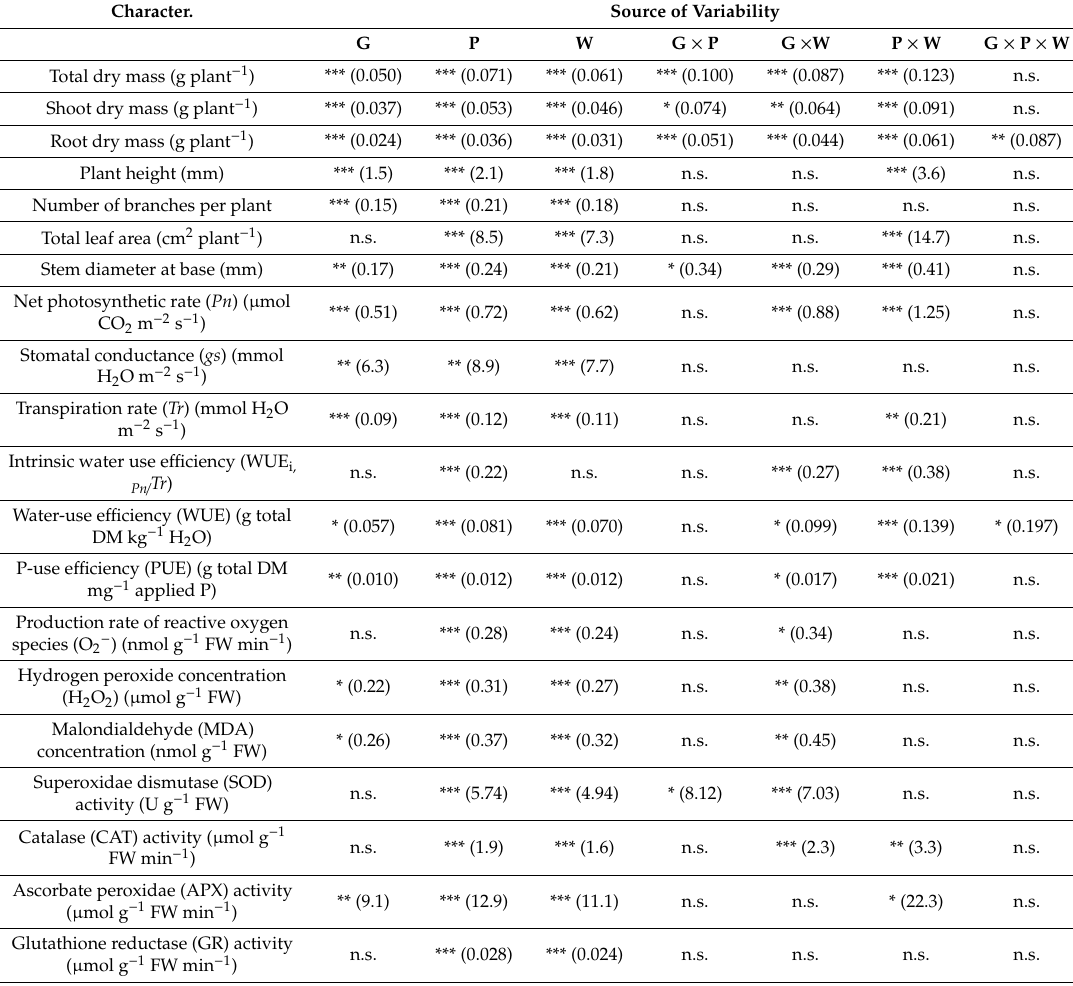
Table 1. Significance of the sources of